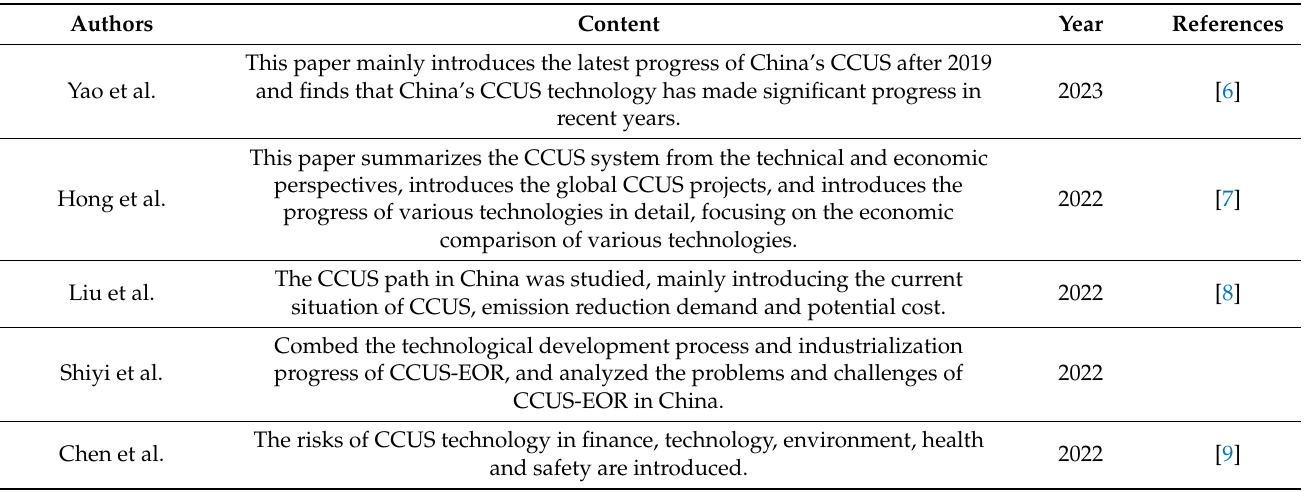
Table 1. Summary of CCUS-related